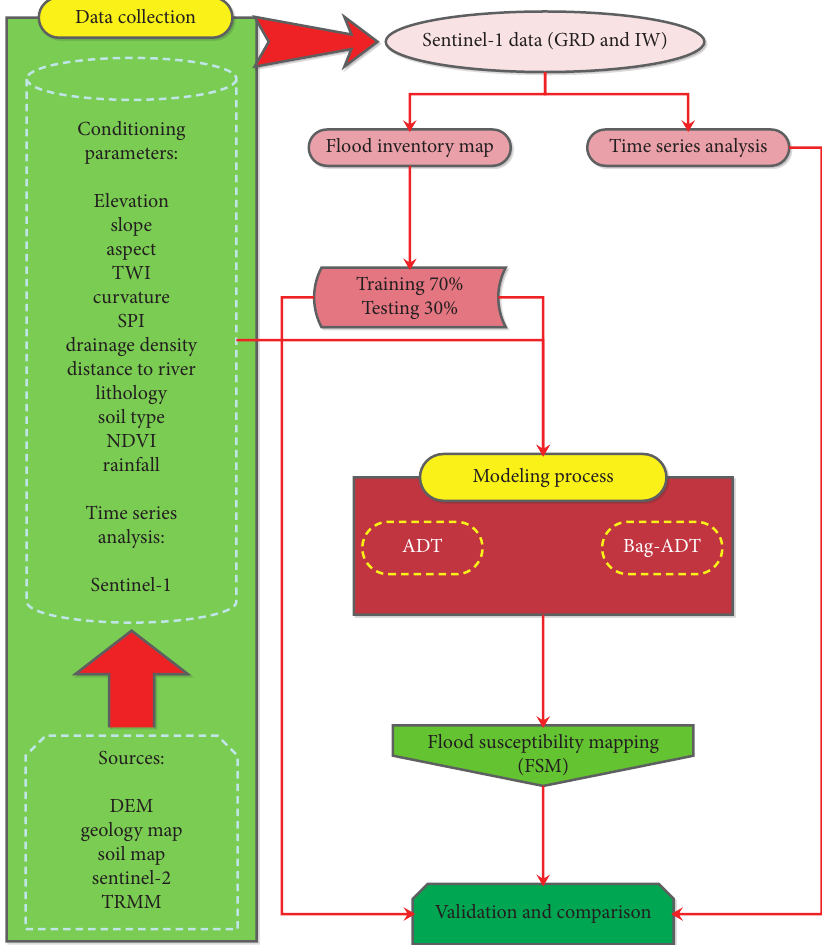
Figure 3: Methodology of the